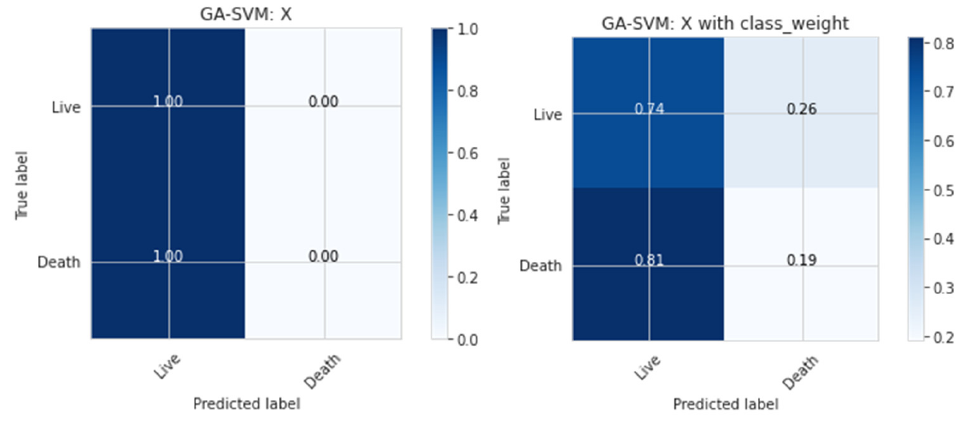
Figure 2. Confusion matrix for the GA/SVM approach.